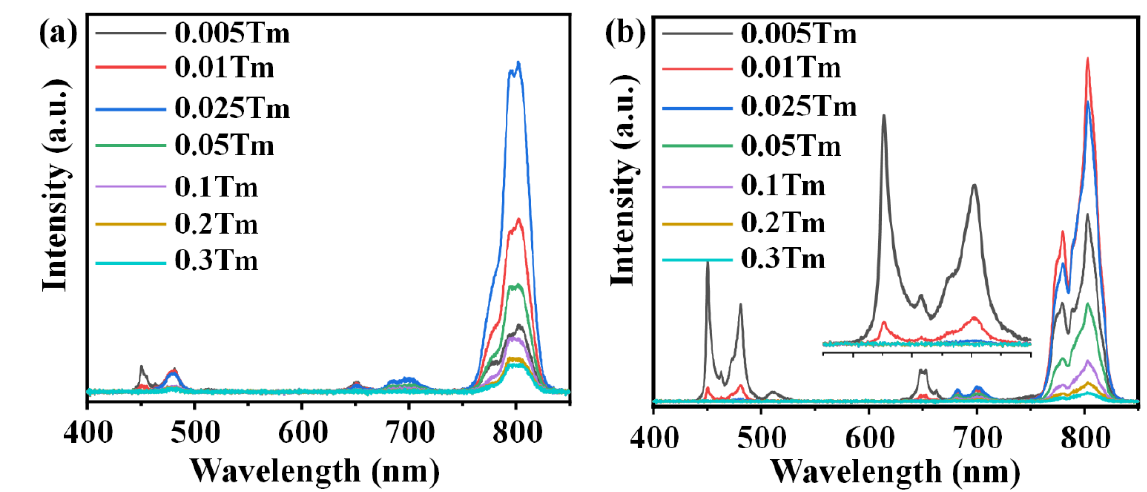
Figure 4. UC emission spectra of 1.0Yb 3+ - y Tm 3+ co-doped ( a ) PG and ( b ) GC excited by a 980 nm LD. ( y = 0.005~0.3).